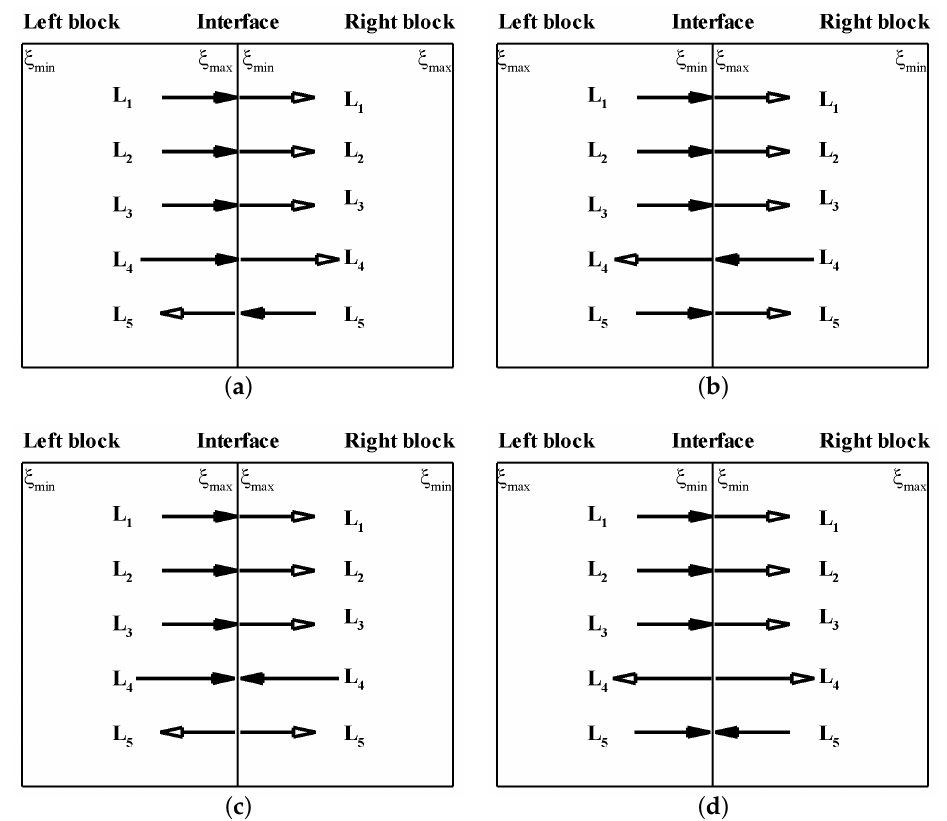
Figure 1. Various block grid orientations and the direction of characteristic waves at the